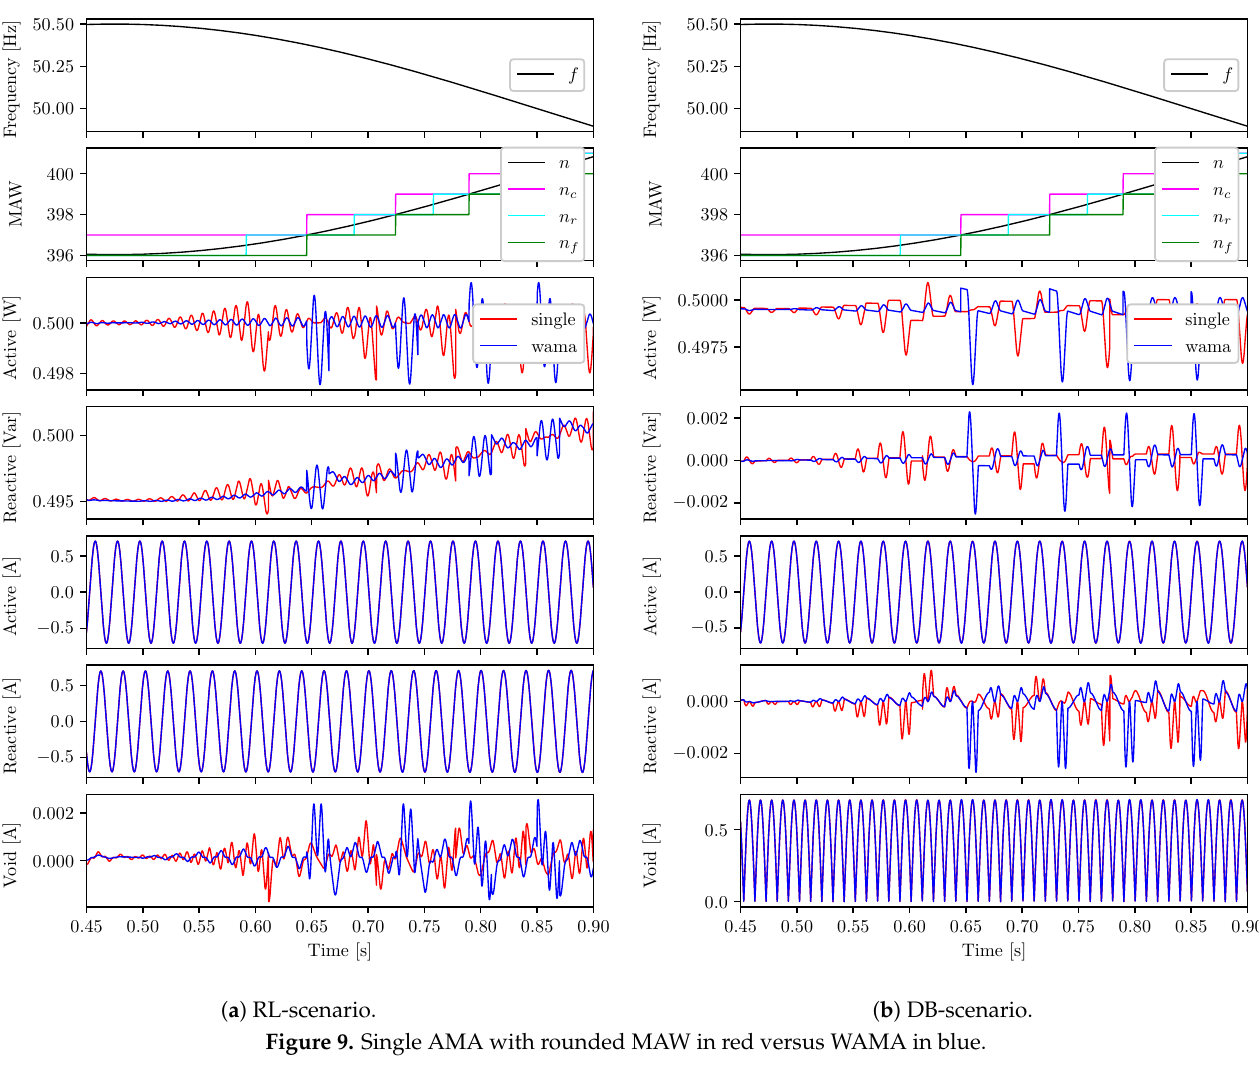
Figure 9. Single AMA with rounded MAW in red versus WAMA in